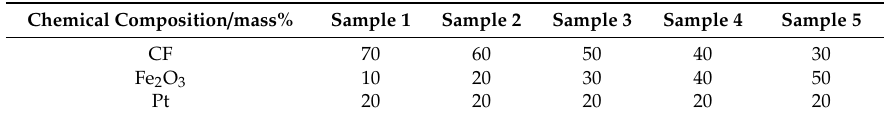
Table 2. Chemical composition of standard